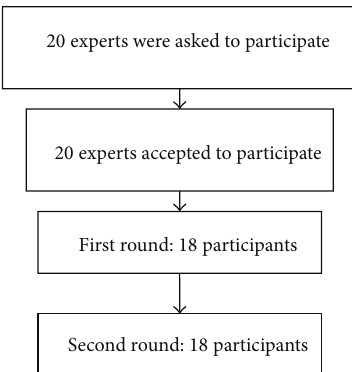
Figure 1: Flow of participants through the Delphi